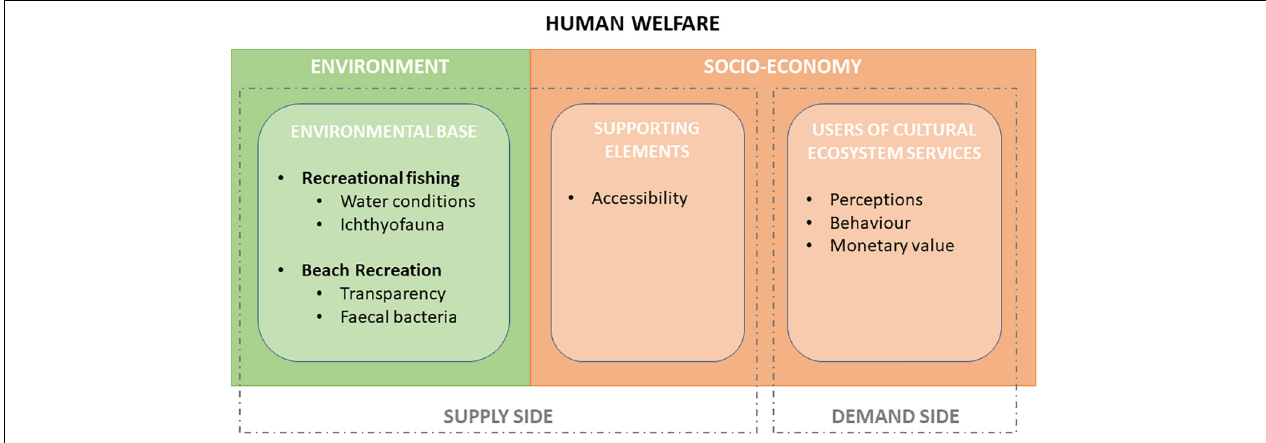
FIGURE 5 | Framework to analyze the human welfare change in the Nerbioi estuary after ecological restoration. Figure 2 has been adapted here to reflect the elements considered in the analysis of the changes in recreational ecosystem services of the Nerbioi estuary.